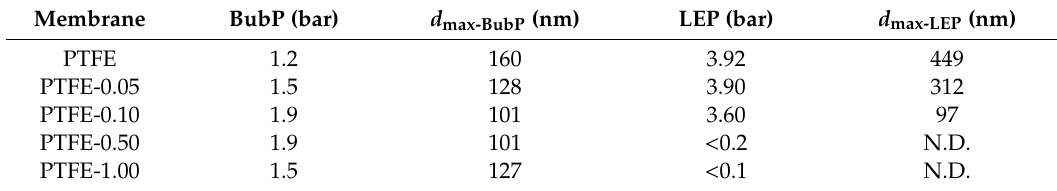
Table 2. Results of bubble point pressure (BubP) and liquid entry pressure (LEP) and maximum pore